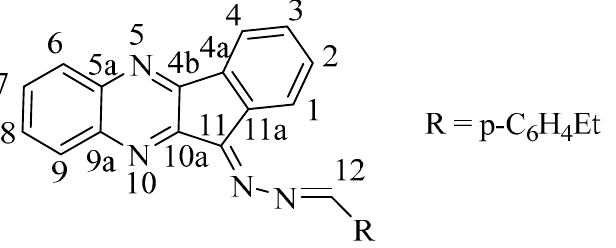
Scheme 2. Synthesis of title compound 3 .